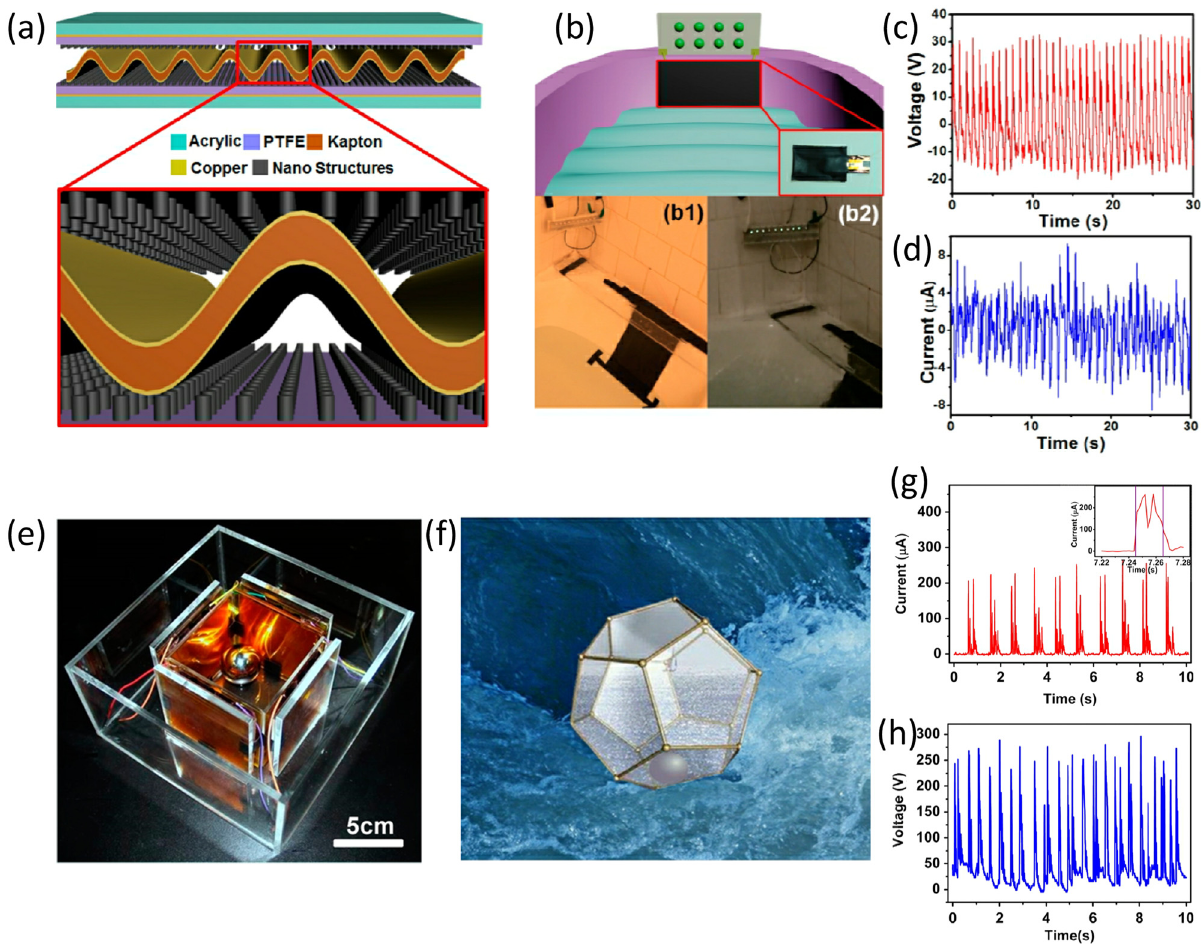
Figure 5: ( a ) Schematic diagram of the wavy structure TENG, ( b ) photograph of wavy - shaped TENG lighting LED in pool test, ( c and d ) output voltage and current of TENG triggered by water wave [ 57 ] , ( e ) photo of boxed TENG [ 58 ] , ( f ) schematic diagram of dodecahedron TENG, and ( g and h ) recti fi ed output voltage and current of dodecahedron TENG in water [ 60 ]